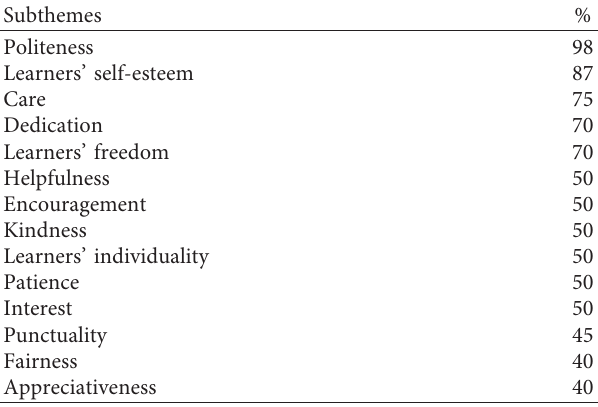
Table 5: Emerging subthemes of teachers’ (dis)respect for learners. Subthemes %